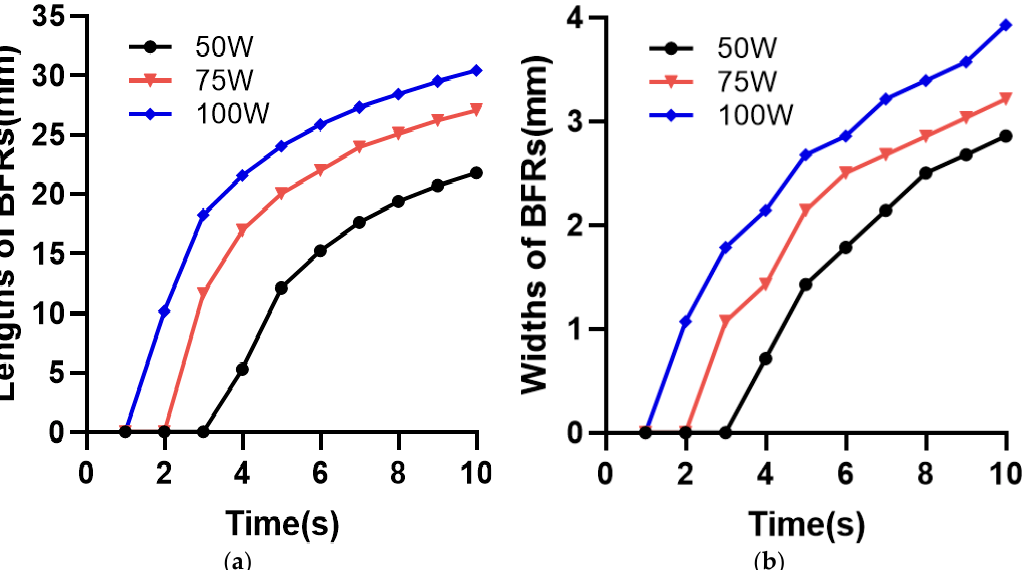
Figure 12. ( a ) Lengths and ( b ) widths of the BFRs during ultrasonication with di ff erent power in the phantom.